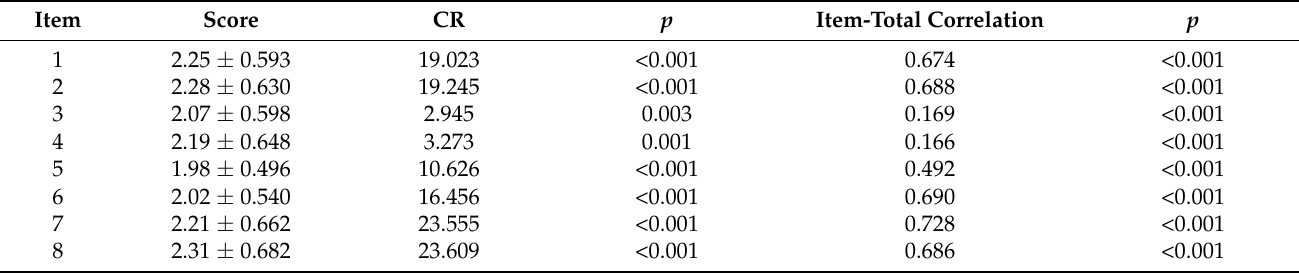
Table 2. Item analysis of the PrEP adherence